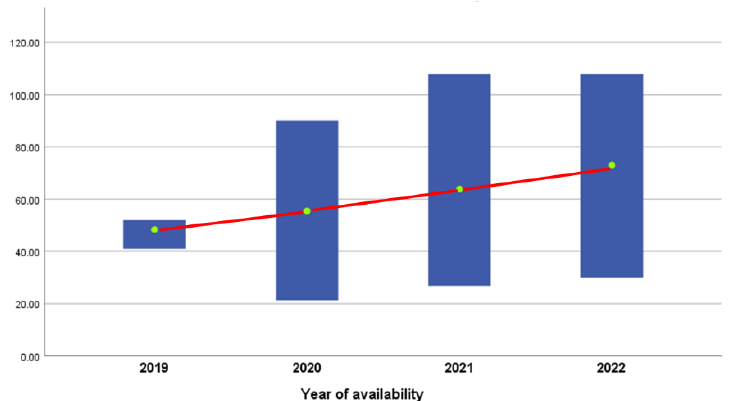
Figure 6. Range bar variation (min, max, mean) representation of battery’s energetic capacity vs. year of availability in market.